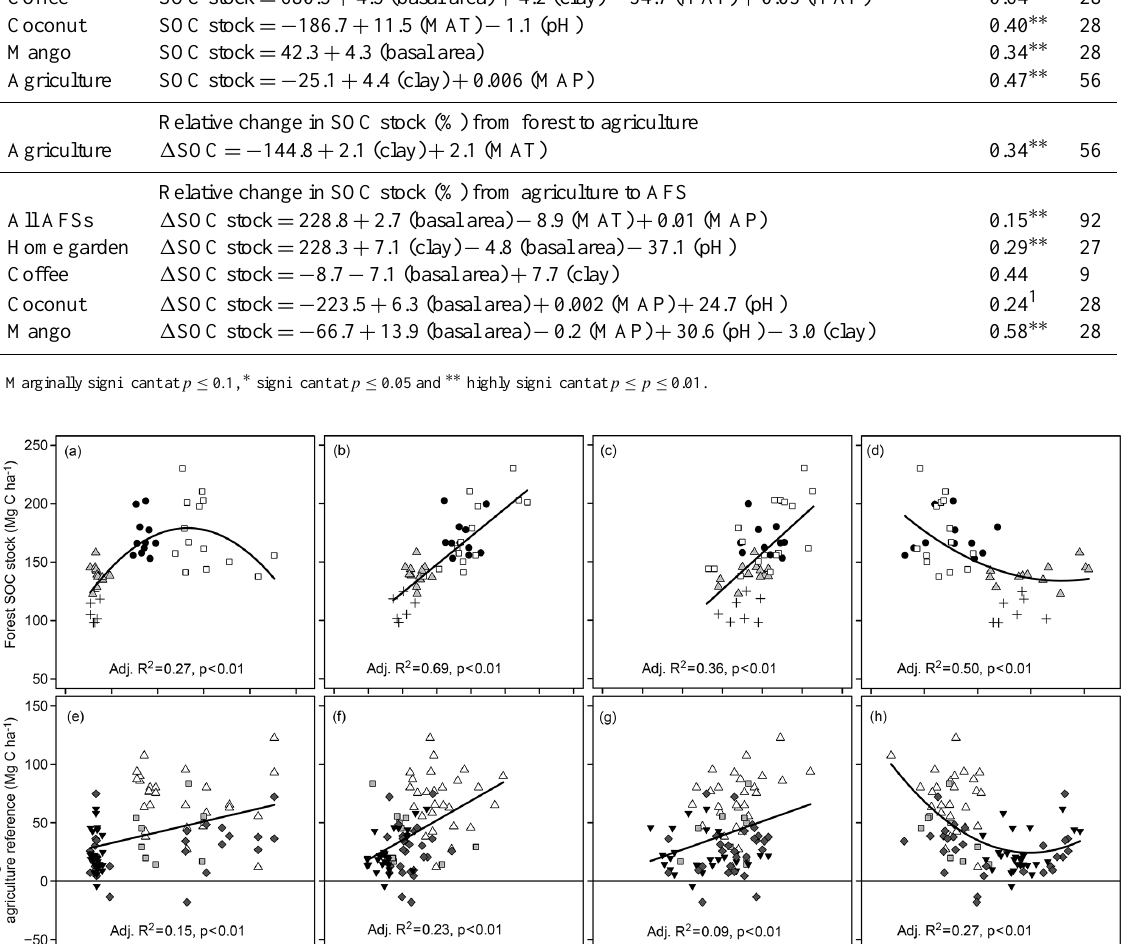
Figure 4. Scatterplots (a-d) showing the relationship forest SOC stock (top 1m) exhibits with 2 MAP (mm), basal area (m 2 ha -1 ), soil texture (clay percent), and soil pH across humid (  ), 3 moist-sub-humid ( ), dry sub-humid ( ) and semi-arid (+) climate zones. Scatterplots (e-h) 4 show the relationship SOC stock changes (from agriculture reference) have with the same 5 soil and biophysical variables in homegarden ( ), coffee ( ), coconut ( ) and mango ( ) 6 AFSs. 7 8